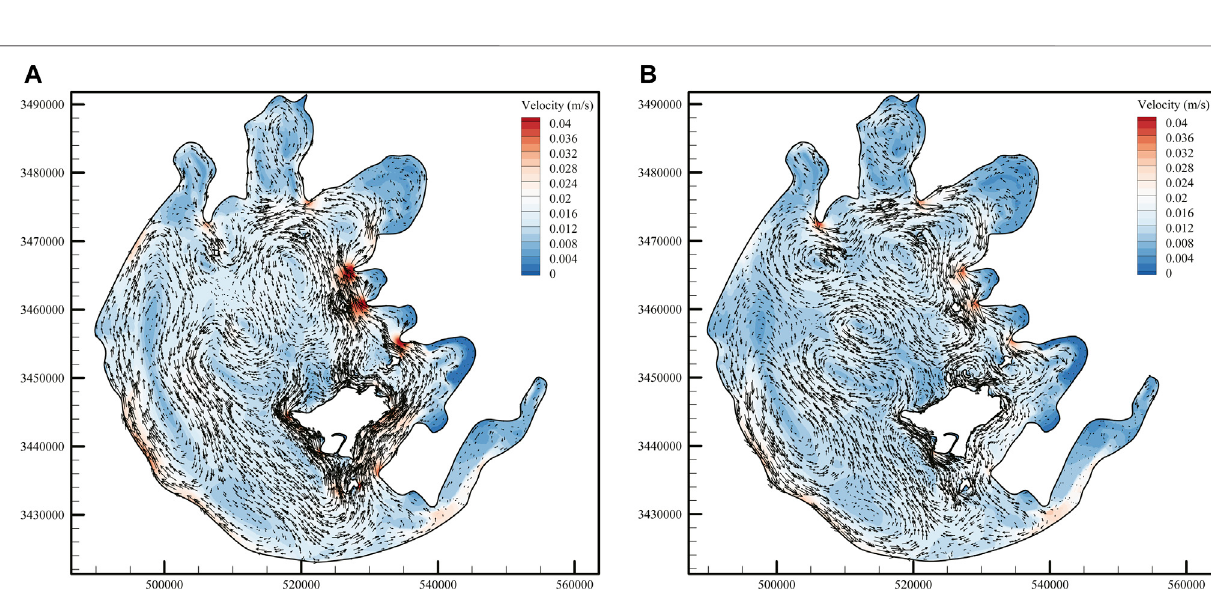
Frontiers in Environmental Science |